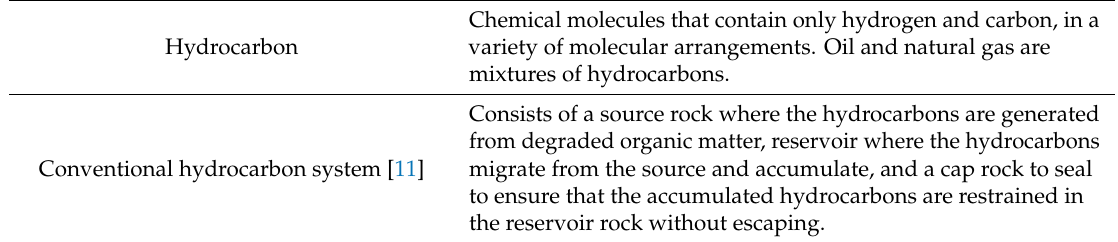
Table 1. Common definitions associated with oil and gas bearing